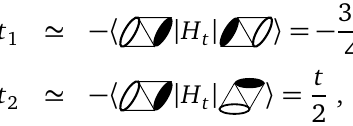
Figure 4: Fermion dispersion relation (cid:34) ( k ) as function of momentum along the high symmetry line Γ − M − K − Γ in the vicinity of the exactly solvable line for δ t Blue solid line: perturbative result from Eq. (20), red line with circles: exact diag- onalization results on a 4 × 4 lattice, green line with squares: exact diagonalization results on a 6 × 6